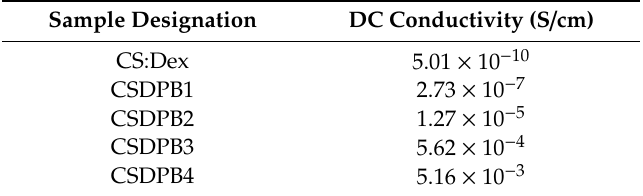
Table 1. DC conductivity for pure CS:Dex and blend electrolyte films at room